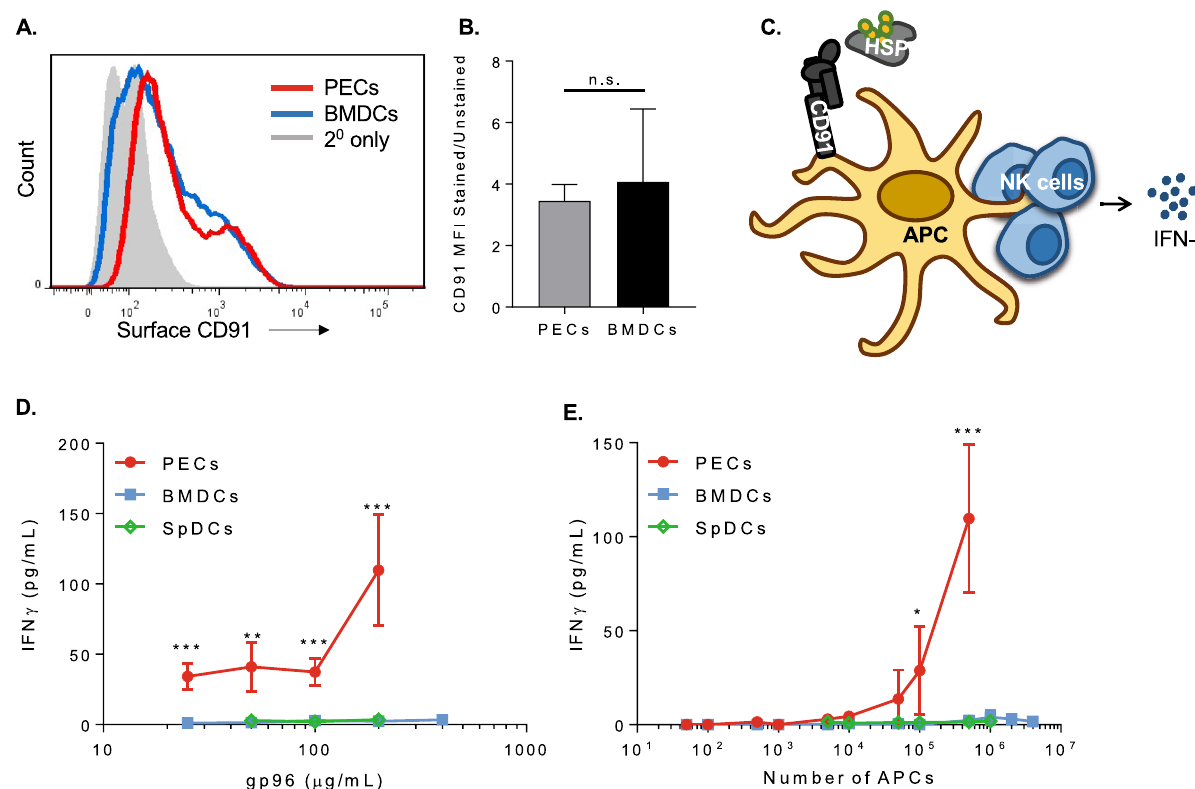
Figure 1. PECs but not BMDCs are capable of inducing NK cell IFN- γ production in response to gp96. (A and B) PECs and BMDCs were stained for CD91 and analyzed by flow cytometry. (A) A representative histogram is shown and (B) MFI is pooled from 3 independent experiments and graphed. (C) Illustrated setup of in